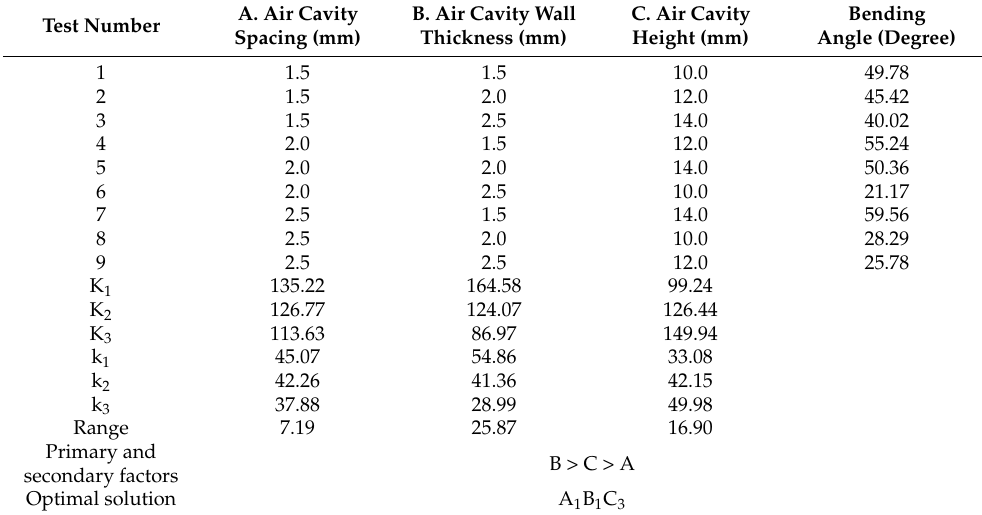
Table 2. Orthogonal test analysis